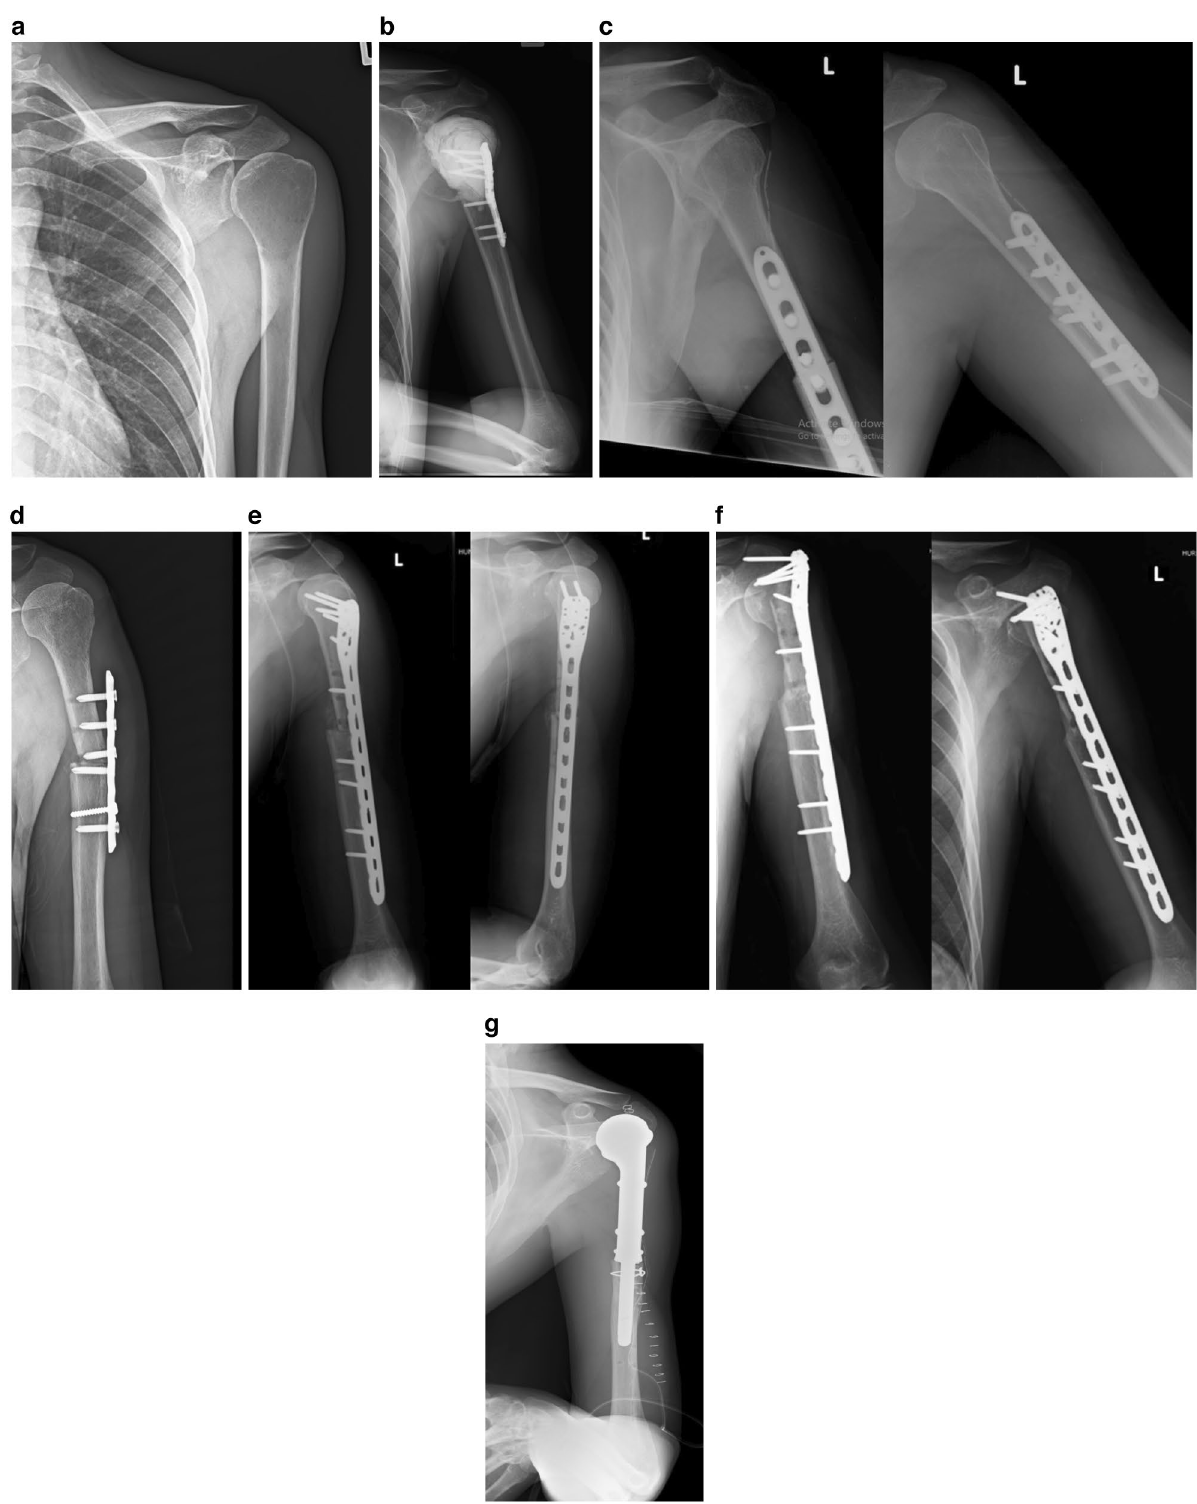
Figure 2. A 31-year-old male with giant cell tumor of the proximal humerus. ( a ) Pre-operative anteroposterior radiograph. ( b ) Six months after extended curettage with phenol and bone cement, tumor recurrence was detected. ( c ) Wide excision and allograft reconstruction was performed. ( d ) Three months later, failure of the implant was found. ( e ) Revision surgery with locking plate and screws was done. ( f ) Fifteen months after the revision procedure, fracture and lysis of the allograft occurred. ( g ) Finally, proximal humeral endoprosthesis was